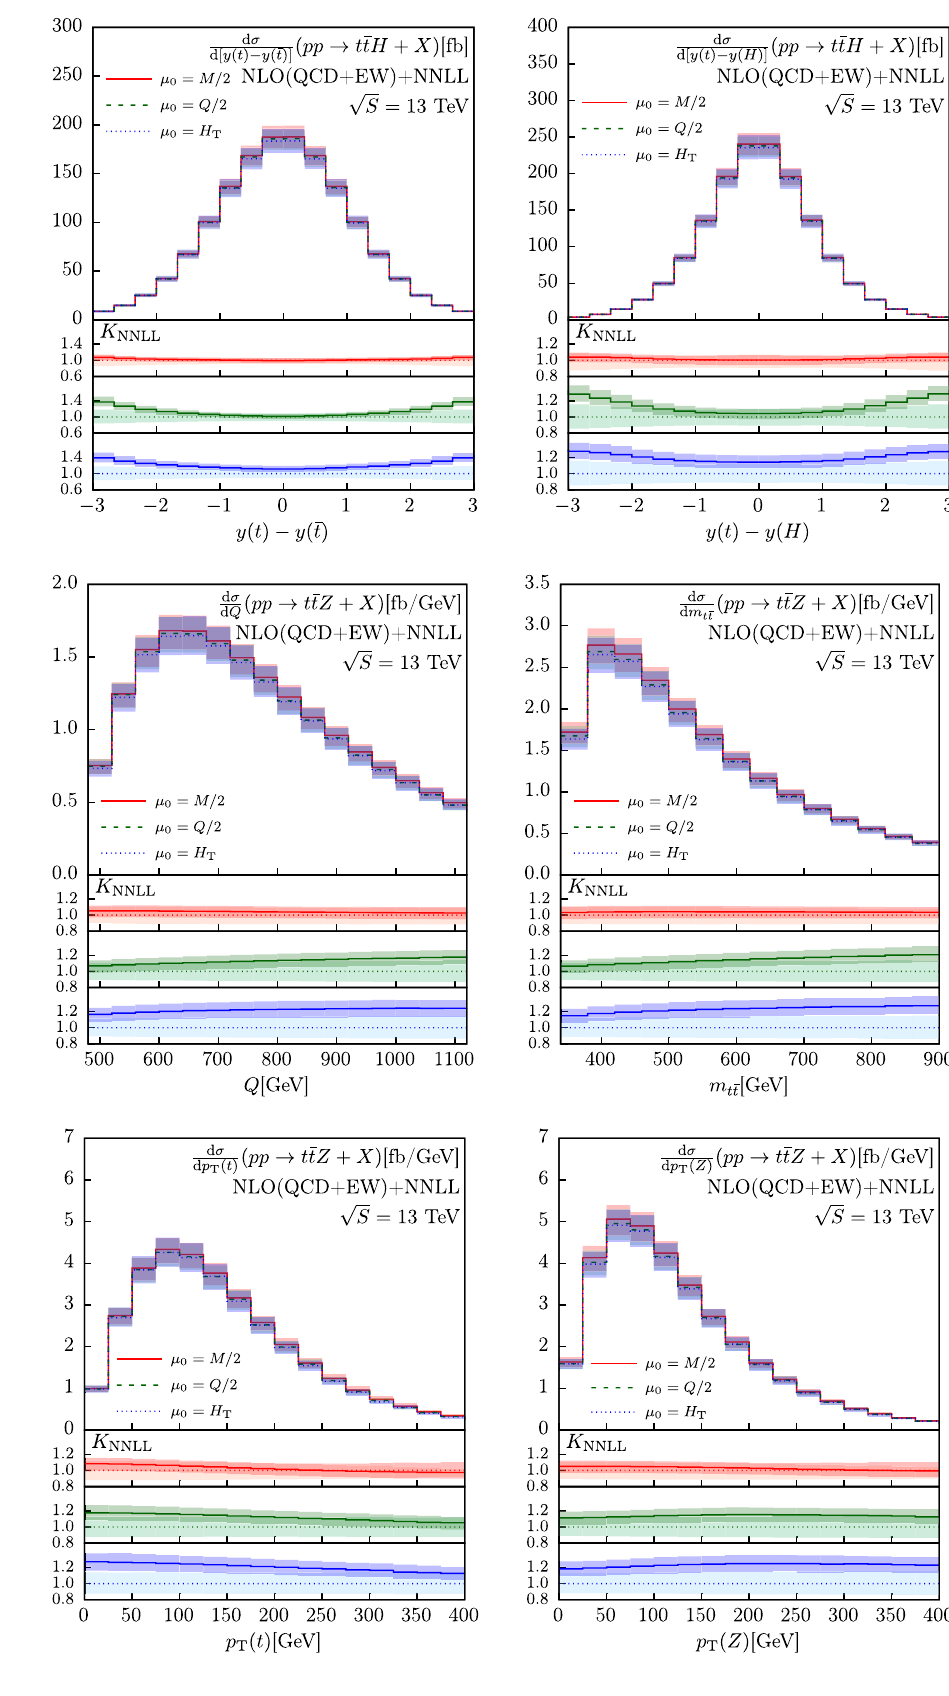
Fig. 13 Predictions for pp → t ¯ tH differential cross section in y ( t ) − y ( ¯ t ) and y ( t ) − y ( H ) . Lower panels show ratio of the NLO(QCD + EW) + NNLL and NLO(QCD + EW) distributions for three central scale choices μ 0 = M / 2, μ = Q / 2 and μ = H T . Only 0 0